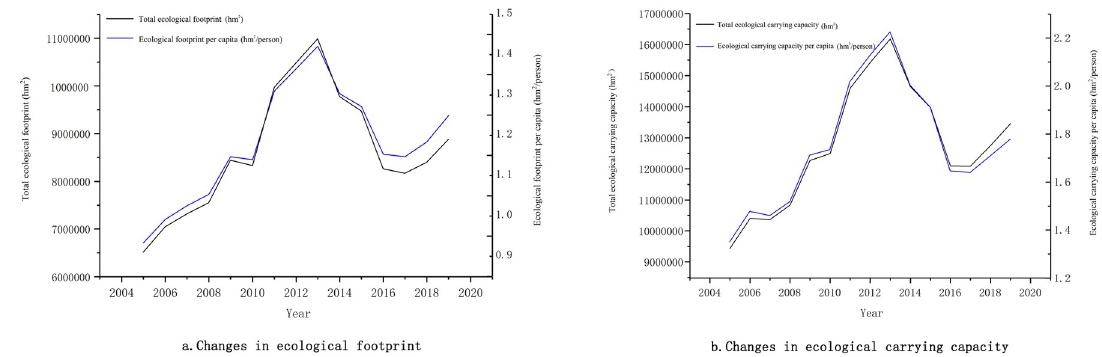
Fig 2. Trends in ecological footprint and ecological carrying capacity of Shenyang City, 2005–2019. a. Changes in ecological footprint. b. Changes in ecological carrying